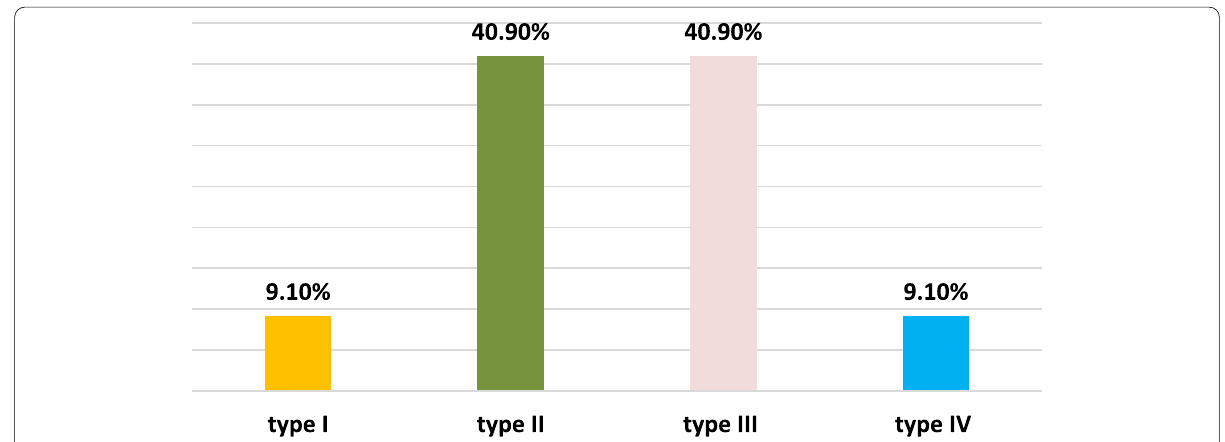
Fig. 2 Types of Martin–Gruber anastomosis in the studied forearms; MGA type I, MGA type II, MGA type III, and MGA type